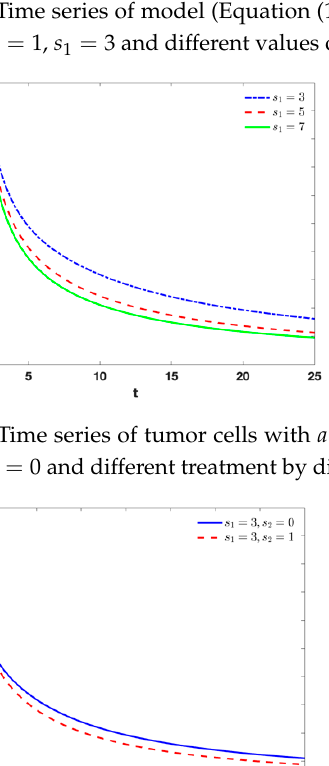
= 1, k = 0.5, b = 1, c = 3, d = 2.5, 1 1